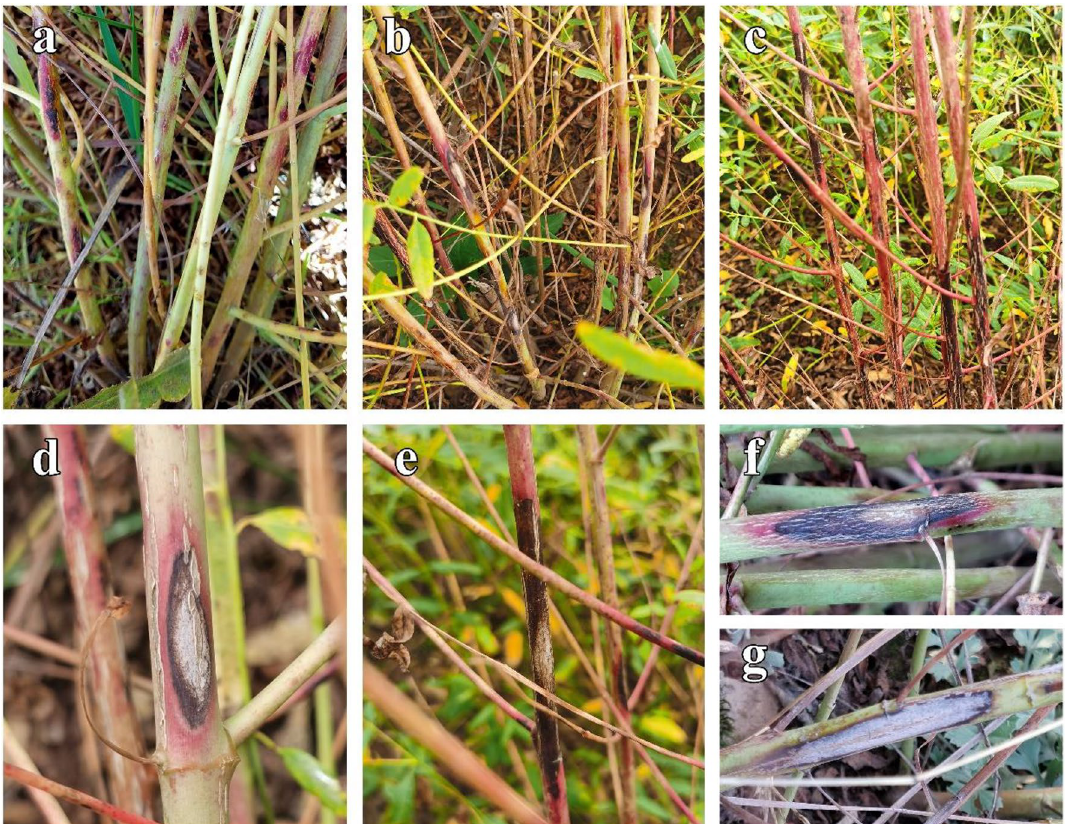
Figure 1. The symptom of stem necrosis lesions disease on Luobuma caused by B. exigua in the field. ( a ) early stage of stem necrosis lesion, ( b ) mid stage of stem necrosis lesion, ( c ) late stage of stem necrosis lesion and ( d–f ) the detail symptoms of stem necrosis lesion